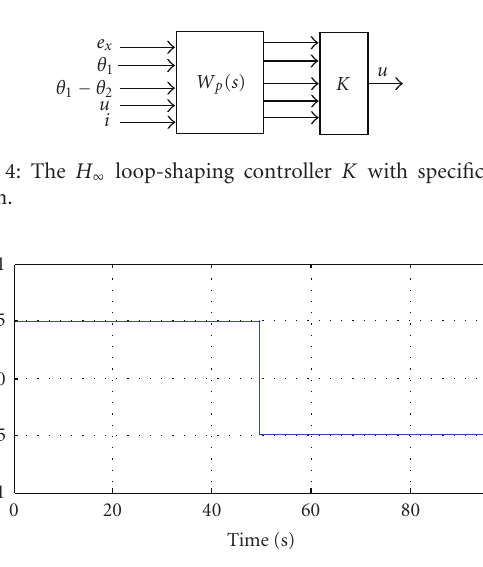
Figure 5: Command signal requiring the cart to move from 0.5 m to − 0 . 5 m.